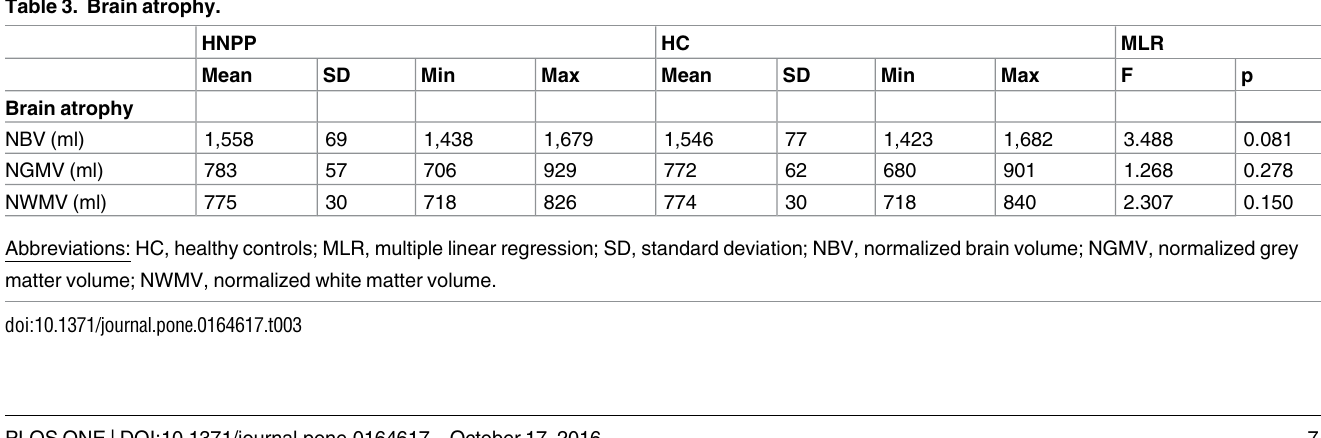
HNPP patients. Despite patients having visual acuity within normal range, patients reported problems with peripheral vision in comparison to HC. VEP latencies were prolonged in patients in comparison to healthy subjects. Average retinal OCT layer thicknesses in patients